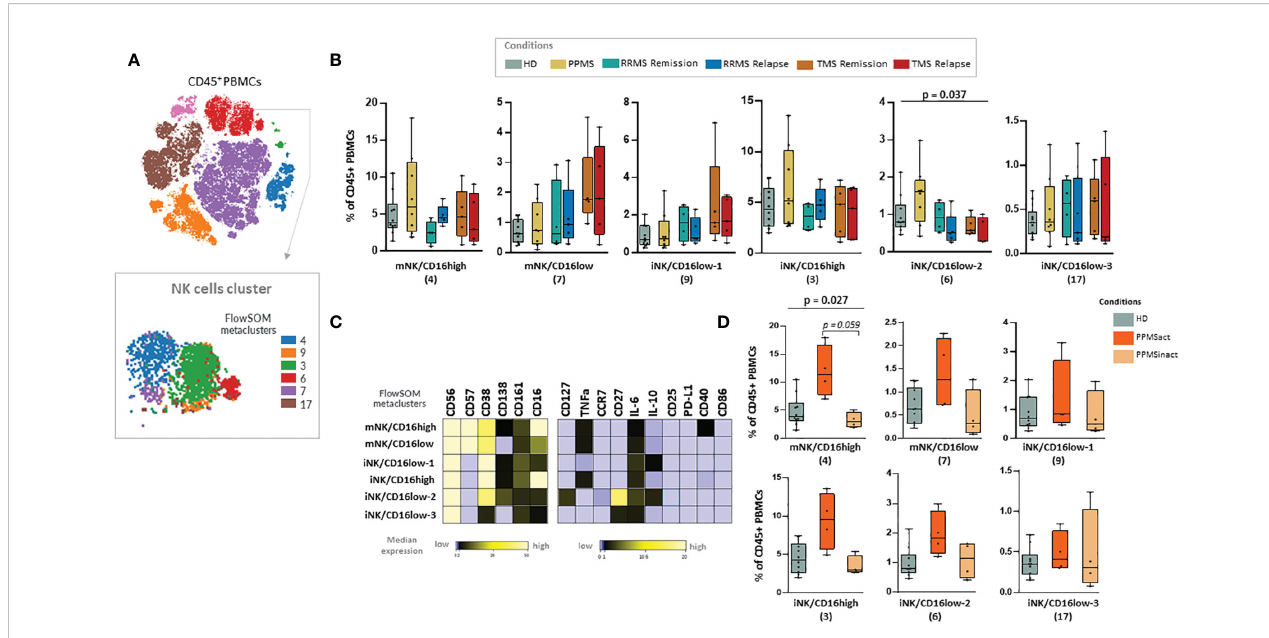
FIGURE 6 Natural killer (NK) cell populations expanded in PPMS patients characterised by the presence of leptomeningeal enhancement in MRI. (A) FlowSOM identi fi ed metaclusters in NK cells (a representative example from one healthy donor is shown here). (B) Box plots showing the frequency (expressed as % of CD45+ cells) of each NK cell metacluster in peripheral blood mononuclear cells of patient subgroups and healthy donors (n=10). MS patients strati fi ed in different disease subgroups (PPMS; n=9, RRMS; n=9, TMS; n=10). RRMS and TMS were further subdivided in those in remission (RRMS; n=4, TMS; n=5) and relapse (RRMS; n=4, TMS; n=5). A tentative biological name was assigned to each metacluster based on marker expression, shown in the heatmap (C) . (D) Box plots showing the frequency (expressed as % of CD45+ cells) of each NK cell metacluster in peripheral blood mononuclear cells of PPMS patients subgrouped in those characterised by the presence of leptomeningeal enhancement (PPMSact) and those without (PPMSinact), as assessed by novel MRI techniques (shown in material and methods). p < 0,05 was considered signi fi cant, non-parametric Kruskal Wallis test with correction for multiple comparisons (FDR) was applied, * p<0,05). PPMS, Primary Progressive Multiple Sclerosis; act, active; inact, inactive; RRMS, Relapsing Remitting Multiple Sclerosis; Rem, Remission, Rel, Relapse; TMS, Tumefactive Multiple Sclerosis; HD, Healthy donors; IQR, interquartile range; t-SNE, t-distributed stochastic neighbor embedding; FlowSOM, Flow Self-Organizing Map; PD-L1, Programmed death-ligand 1; TNF- a , tumor necrosis factor alpha; IL-10, Interleukin 10; IL-6, Interleukin 6; CCR, CC chemokine receptors; FDR, false discovery rate; i, immature; m,